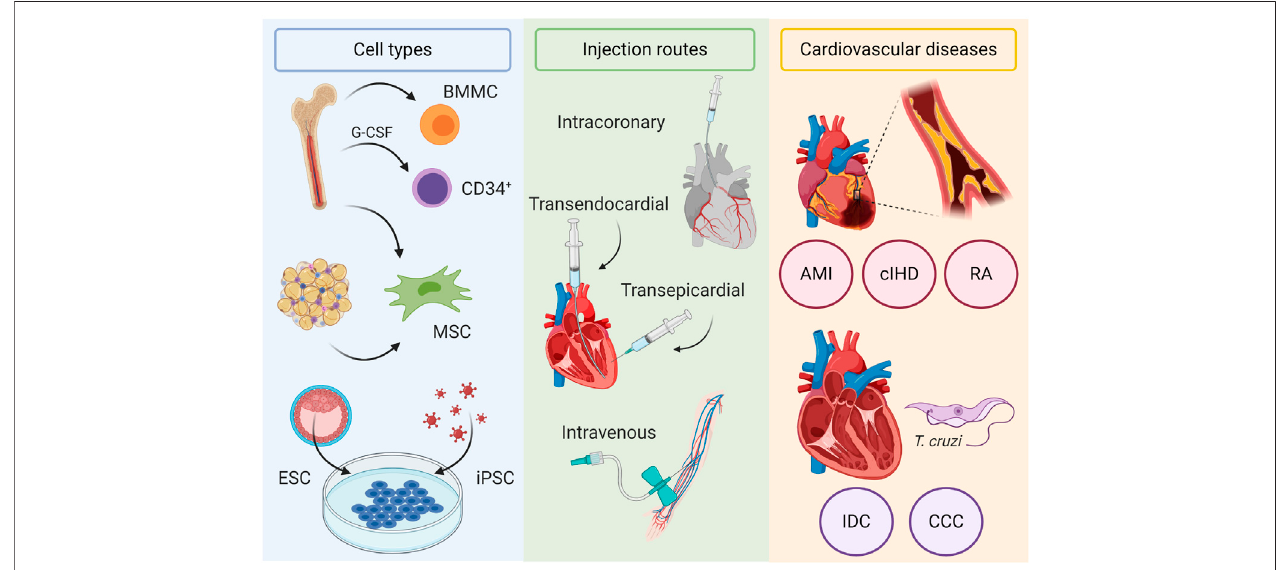
FIGURE 1 | Cell-based therapies for heart failure. Cell types used in clinical trials include bone marrow mononuclear cells (BMMC), CD34 + mobilized with G-CSF, bone marrow and adipose tissue – derived mesenchymal stromal cells (MSC), embryonic stem cells (ESC), and induced pluripotent stem cells (iPSC). Injection routes includeintracoronary, transendocardial, and transepicardial routes, which deliver cells directly inthe myocardium, and intravenously. Cardiovasculardiseases evaluated in clinical trials include ischemic (acute myocardial infarction (AMI), chronic ischemic heart disease (cIHD), and refractory angina (RA)) and nonischemic cardiomyopathies (idiopathic dilated cardiomyopathy (IDC) and chronic chagasic cardiomyopathy (CCC)).